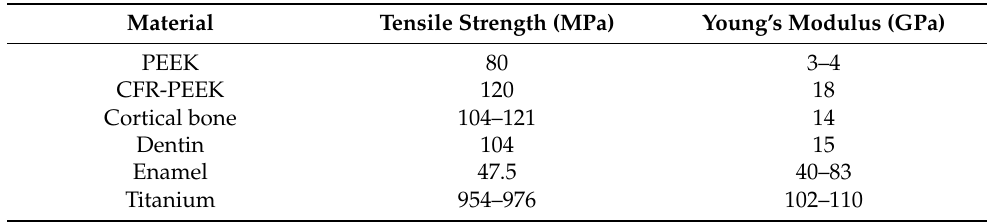
Table 1. Tensile strength and elastic modulus of PEEK, CFR-PEEK and mineralized human tissues. (Reproduced from [38], with permission from © 2016 Elsevier). CFR-PEEK: carbon fiber-reinforced-